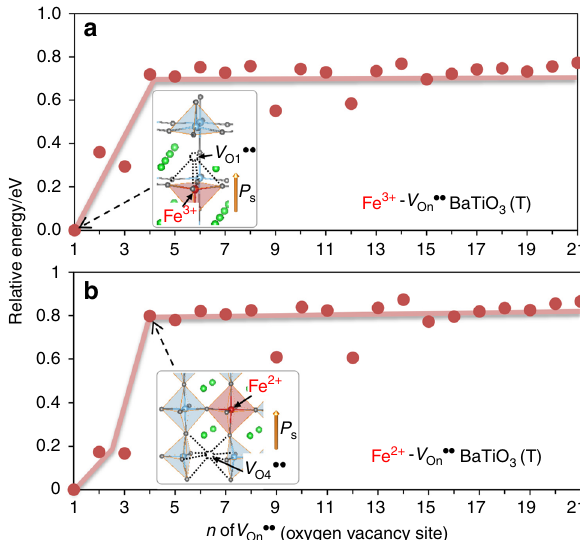
Fig. 2 DFT energies of Fe-doped BaTiO 3 . The horizontal axis n denotes the (cid:129)(cid:129) (oxygen vacancy)-site number in the tetragonal Ba V O n 27 Ti 26 FeO 81 structures (Supplementary Fig. 2), and the vertical axis is the density- functional-theory (DFT) energy with respect to that of n = 1 in the a Fe 3 + and b Fe 2 + cells. V O (cid:129)(cid:129) is adjacent to iron atoms in the n = 1 to 3 cells and is away from iron atoms in the n = 4 to 21 cells, as illustrated in the insets of the n = 1 ( V O1 (cid:129)(cid:129) ) and n = 4 ( V O4 (cid:129)(cid:129) ) cells. Regardless of the valence state of iron, the energies with n = 1 to 3 are 0.6 to 0.8 eV lower than those with (cid:129)(cid:129) is attracted by iron and eventually n = 4 to 21. These results show that V O stabilized on the O1 site (the nearest-neighbor site with Fe).